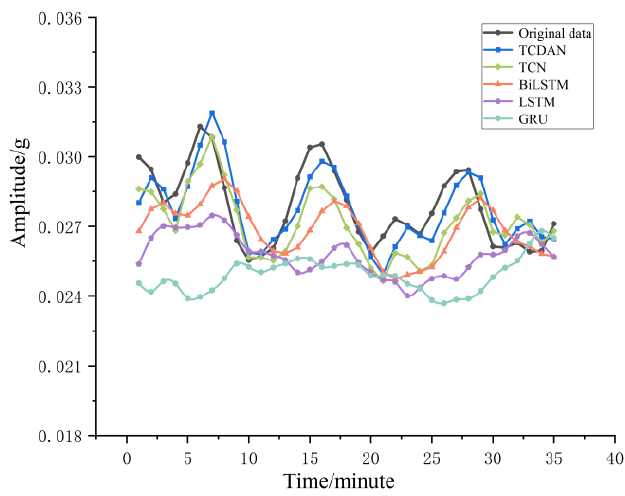
Figure 14. Prediction comparison of the amplitude corresponding to 1 × fi.